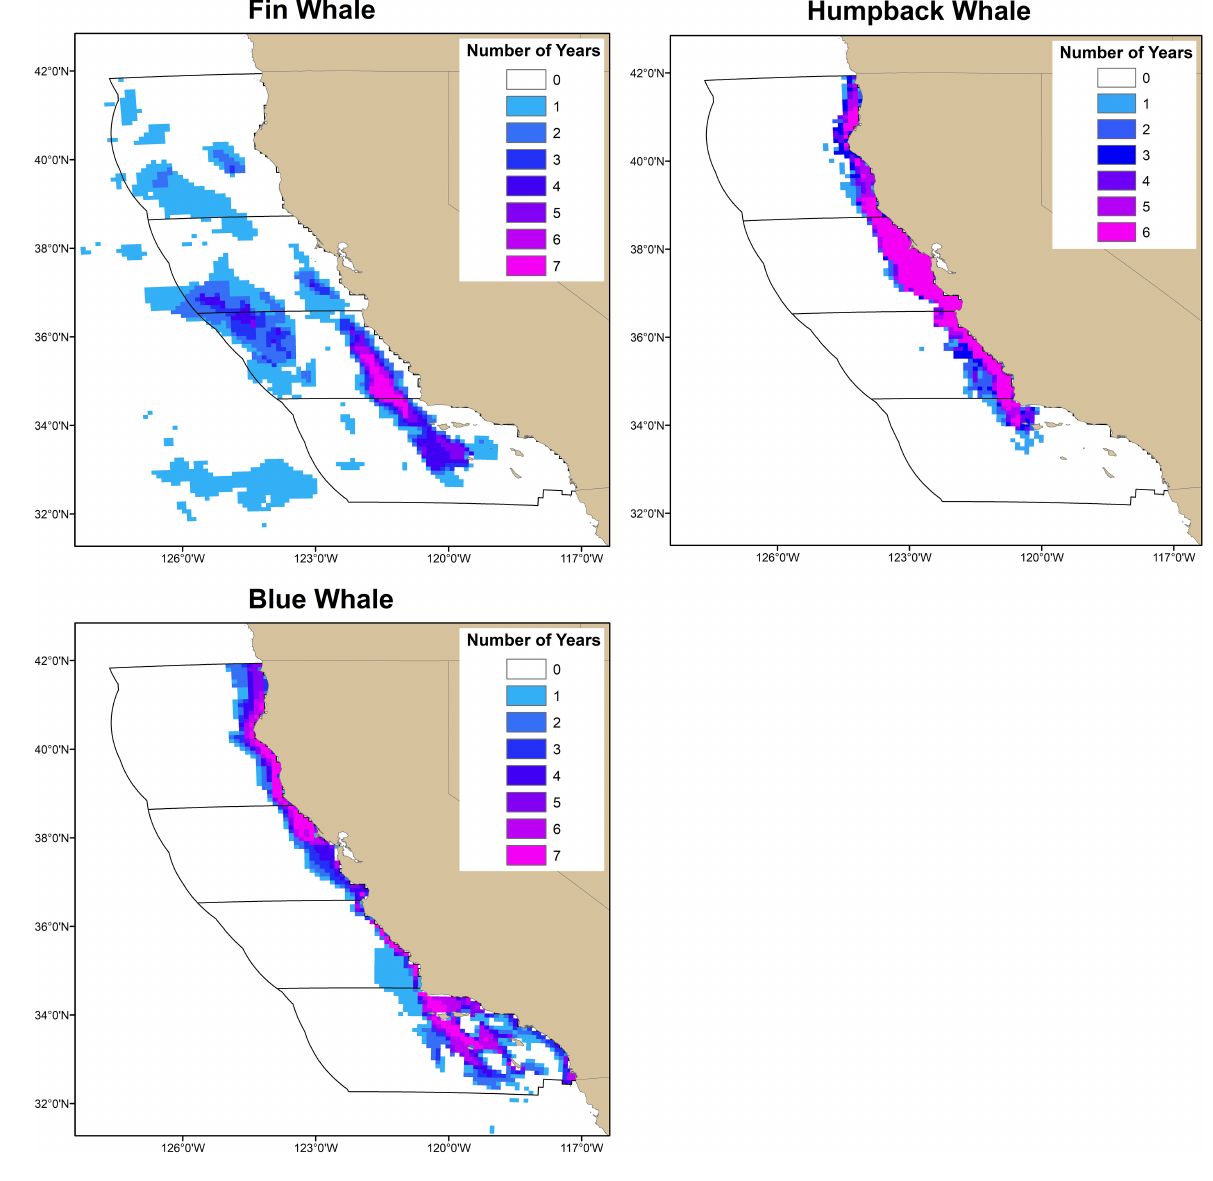
for blue and humpback whales was highest in the